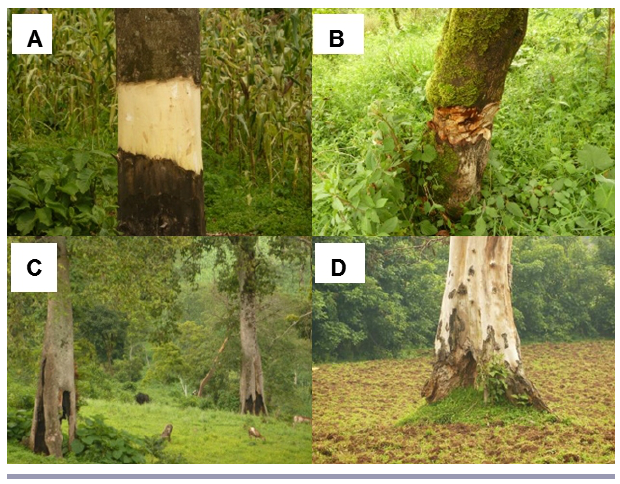
Fig. 8 . Different coping strategies practiced by farmers to remove trees from agricultural fields to mitigate ecosystem disservices: (A) debarking, (B) partial cutting, (C) fire, and (D)